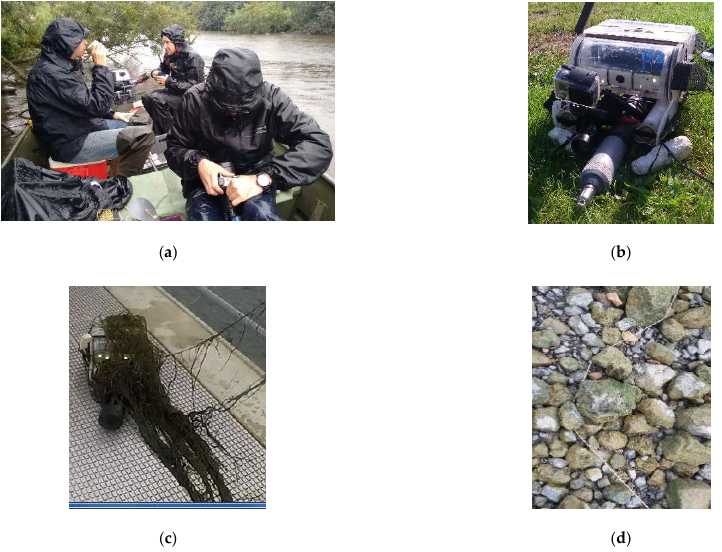
Figure 4. Field challenges: ( a ) operation under rain conditions, where a laptop is needed to operate some drones, ( b ) adjusting the buoyancy of small drones with heavy sensors is a time-consuming task; ( c ) excess of vegetation blocks thrusters; ( d ) tether tangled in rocks/obstacles. Table 7. Categorizing of field occurrences observed in the field; numbering refers to the text in Section